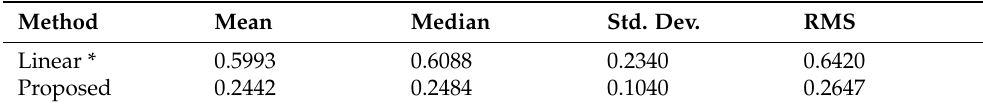
Table 3. Time deviation calibration result (unit: